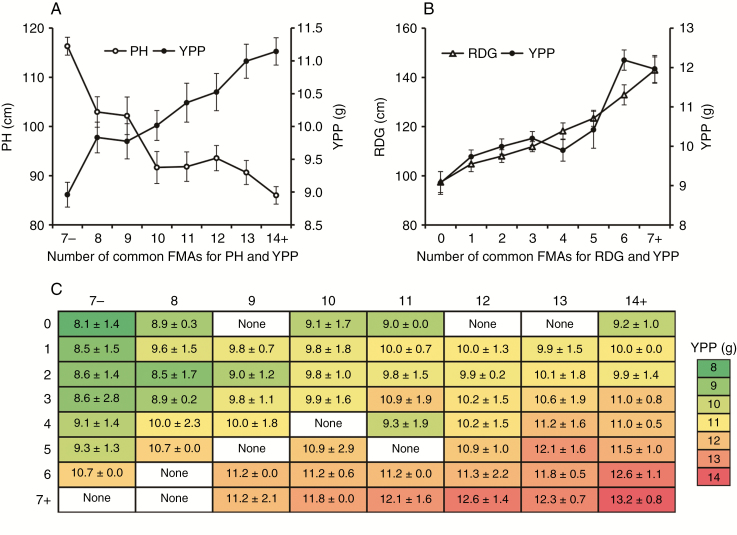
The combined effect of common FMAs in SALs. (A) YPP increased and PH decreased along with the combination of FMAs associated with YPP and PH. (B) YPP and RDG increased along with the combination of FMAs associated with YPP and RDG. (C) The heatmap of YPP based on the combination of FMAs associated with YPP and PH (horizontal) and FMAs associated with YPP and RDG (vertical). YPP, yield per plant; PH, plant height; RDG, root depth at mid-grain fill stage; error bars in (A) and (B) and error values in (C) denote the s.e.